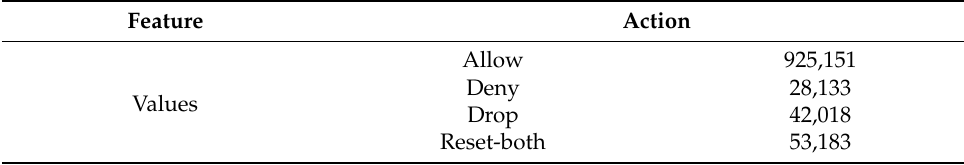
Table 2. Original dataset statistics.